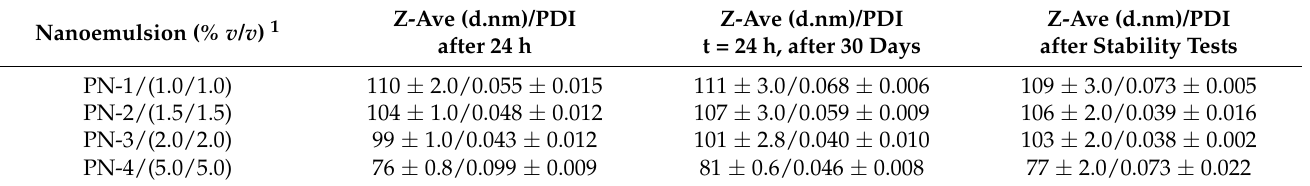
Table 2. Physicochemical properties of selected nanoemulsions containing different peppermint oil concentrations.